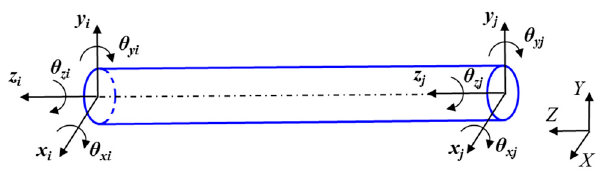
Figure 1. Nodal displacement vector of drill string element.